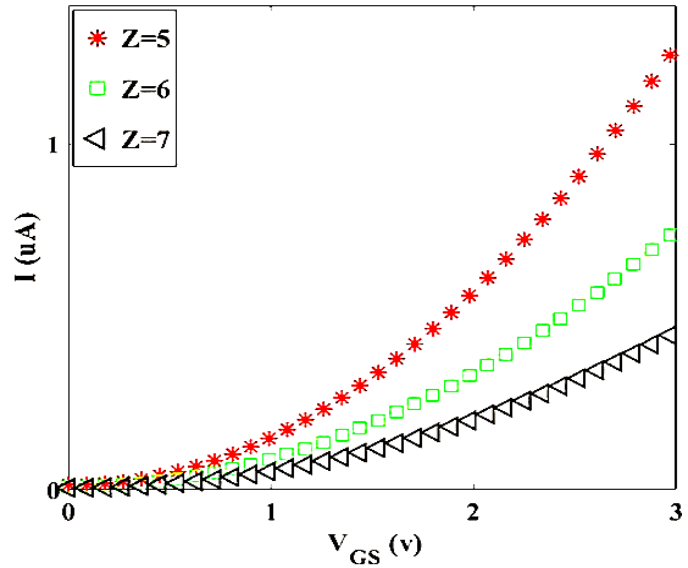
Figure 10. I- VGS characteristic for different values of Z at room temperature (S = 10). Figures 9 and 10 illustrate the geometry effect of graphene twist on the threshold voltage of the proposed transistor that increment in the number of twists leads to decrease in threshold voltage of the transistor and it is very good for high-speed switching of transistor, because it causes less transistor power consumption. Figure 10 indicates that the diameter ( Z ) has an inverse relation on the threshold voltage of the transistor. To compare Figures 9 and 10, it can be noted that to optimize and improve the performance of twisted graphene Schottky transistor, it is better to choose twisted graphene with a smaller diameter. The temperature effect on transistor performance of twisted graphene is explored for three different amounts using thermal voltage ( V T ), as shown in Figure 11. Results indicate that increasing temperature leads to an increment in the mobility of electrons in the channel region of the twisted graphene Schottky transistor. Overall current in a real-world device can be lowered also by experimental non-idealities (e.g., contact resistances), which are typically not reflected in simulations.